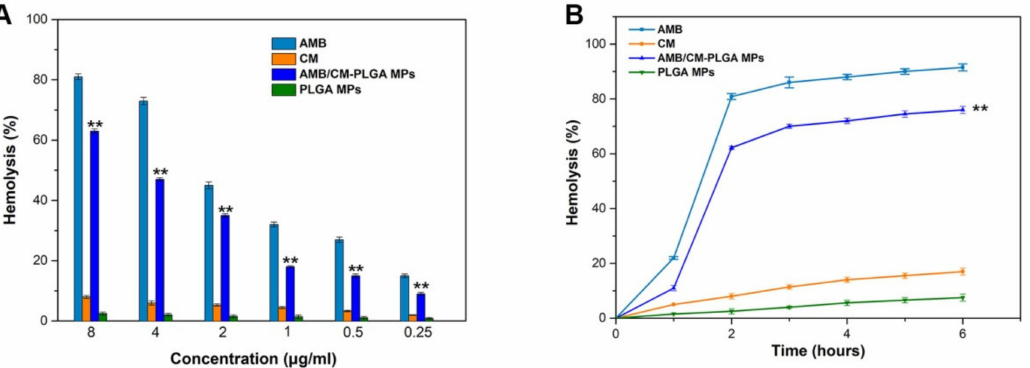
Figure 3. In vitro hemolytic assay. ( A ) Hemolysis of red blood cells following incubation with AMB, CM, AMB/CM-PLGA MPs, and PLGA MPs for 2 h at final AMB concentrations of 0.25 to 8 µ g/mL. ( B ) Hemolysis of red blood cells following incubation with AMB and AMB/CM-PLGA MPs with the concentration of 8 µ g/mL at different times. ** p <